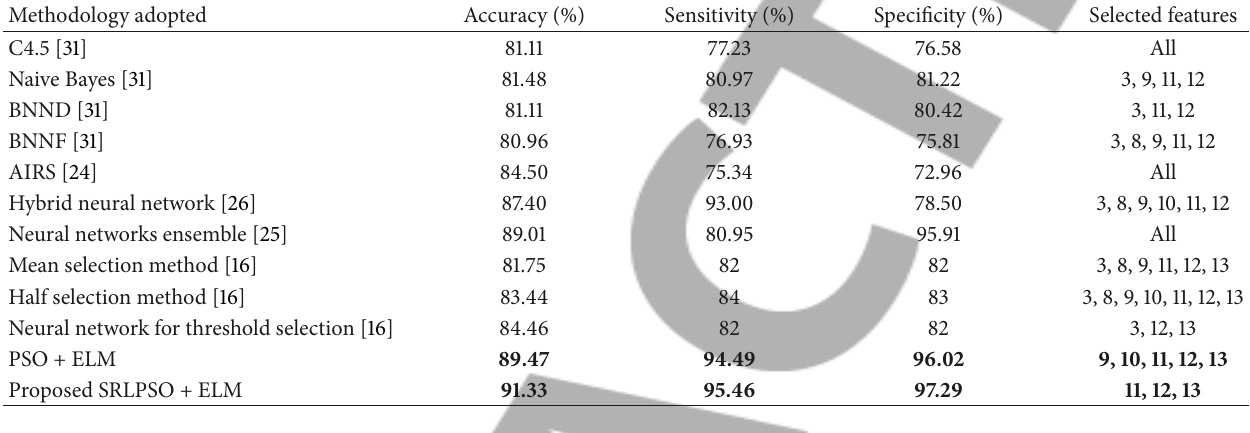
Table 7: Classification results with Cleveland Heart Disease dataset.